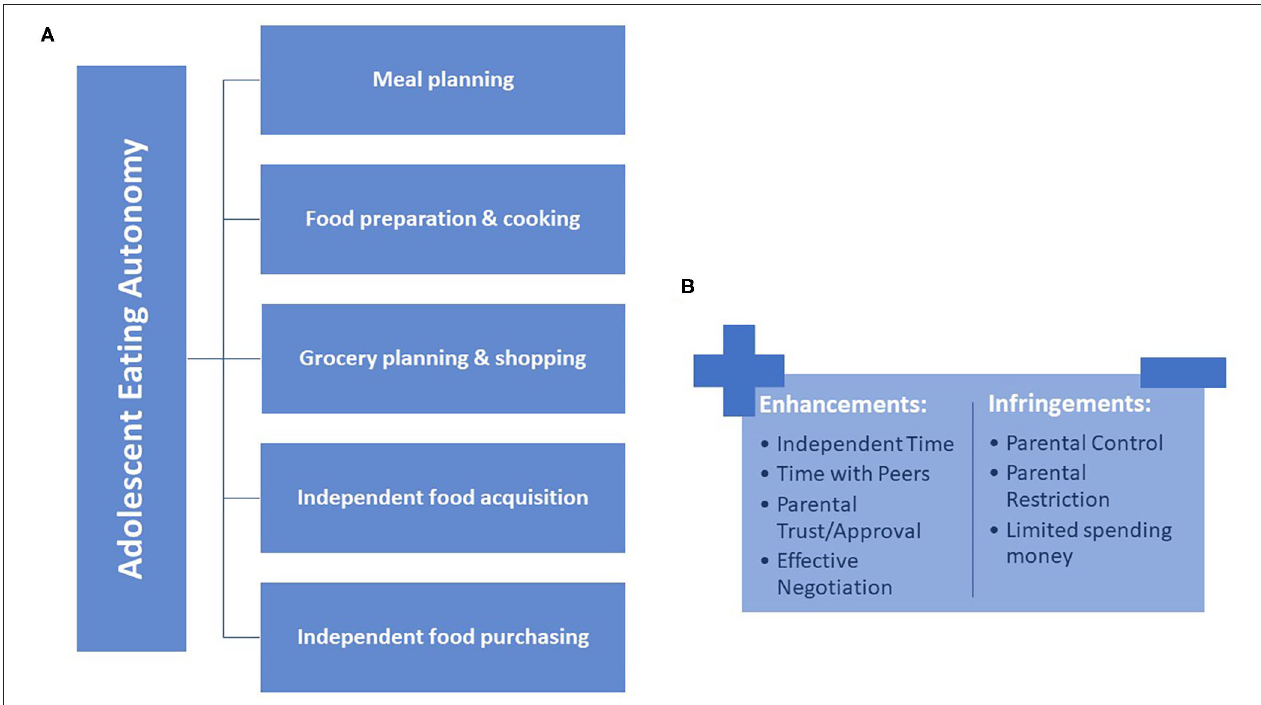
FIGURE 2 | Conceptual elements of adolescent eating autonomy. (A) Shows the emergent autonomous food-related behaviors in which adolescents have a range of engagement. (B) Shows the preliminary factors that may enhance or infringe upon an adolescent’s experience of eating